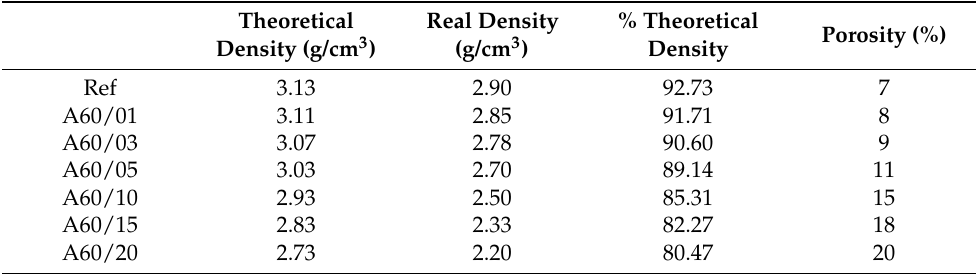
Table 3. Theoretical and real densities (g/cm 3 ) of the composite pad elements prepared with ELT rubber particles A60 (densities are given with ±0.05 error).